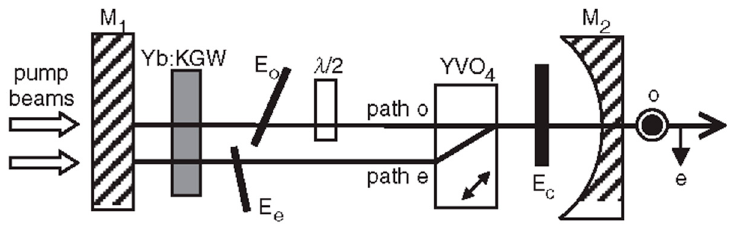
Figure 23. Schematic diagram of dual-frequency Yb:KGW laser [32] . E o , E e , E c : etalon; M 1 : plane- dichroic mirror; M 2 : output coupler.